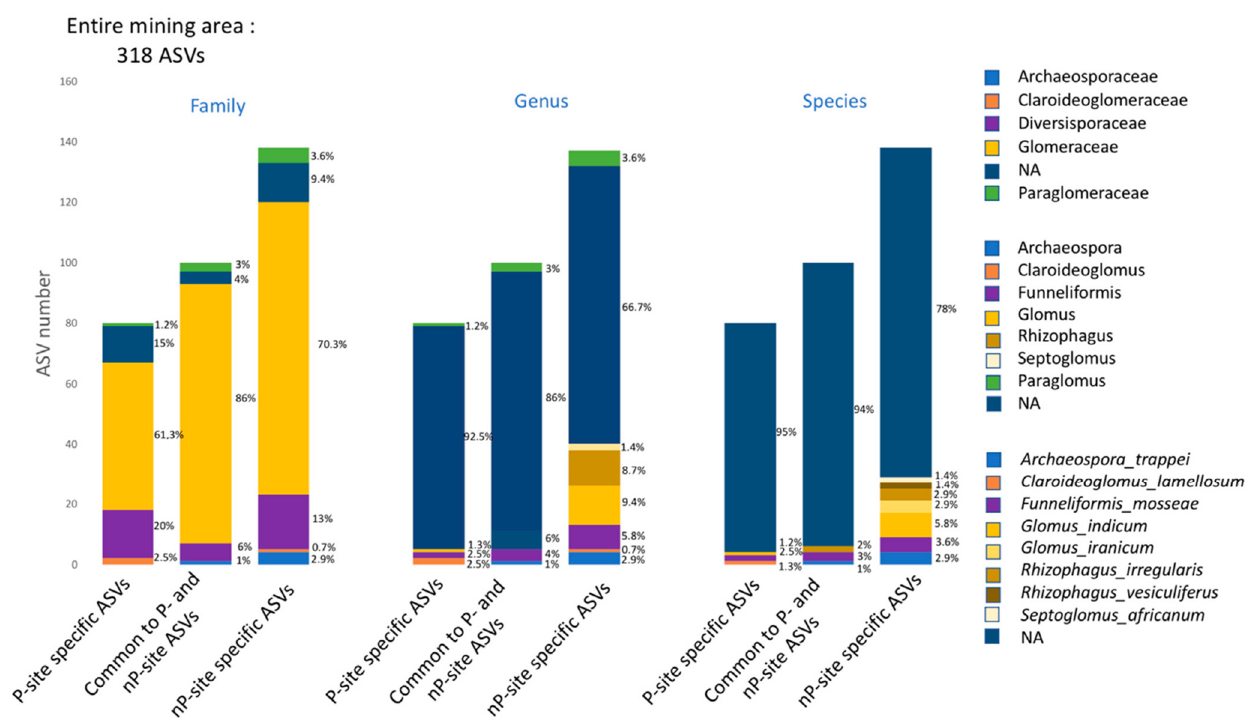
Figure 6. Distribution at the family, genus, and species level of the shared and specific ASVs identified in P and nP sites across the total mining area, NA: no-assigned ASVs.